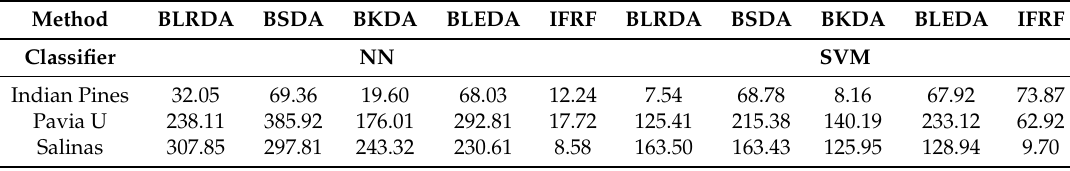
Table 5. Run time of different methods on real-word HSIs